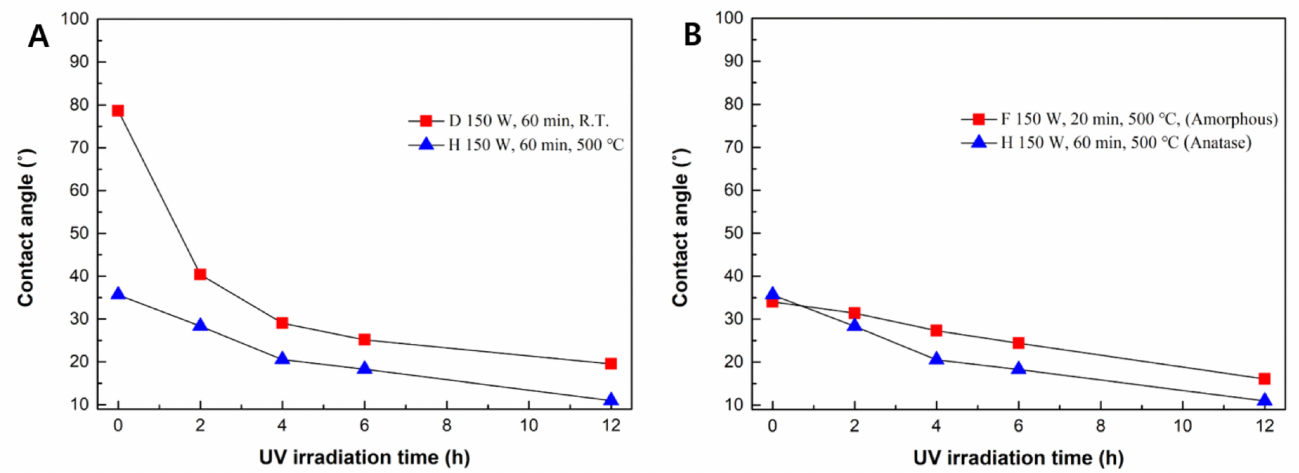
Figure 7. Variation in water contact angles of ( A ) Sample D (non-annealed) and H (annealed at 500 ◦ C) and ( B ) Sample F (amorphous structure) and H (anatase